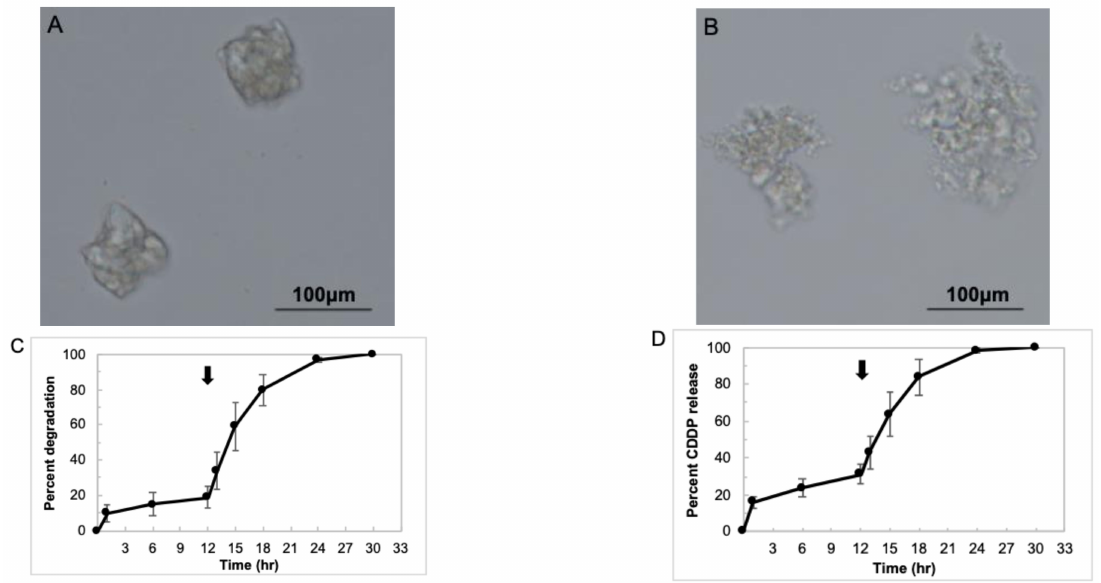
Figure 2. Characterization of CDDP-crosslinked gelatin hydrogels (CCGH). ( A ) A microscopic image of dried CCGH. Scale bar: 100 µ m. ( B ) A microscopic image of CCGH dispersed in DDW. Scale bar: 100 µ m. ( C ) Degradation profiles of CCGH. Collagenase D was added at the time indicated by the arrow (12 h). ( n = 6). Data were represented as mean ± SD. ( D ) CDDP release profiles from CCGH. Collagenase D was added at the time indicated by the arrow (12 h). ( n = 6). Data were represented as mean ±